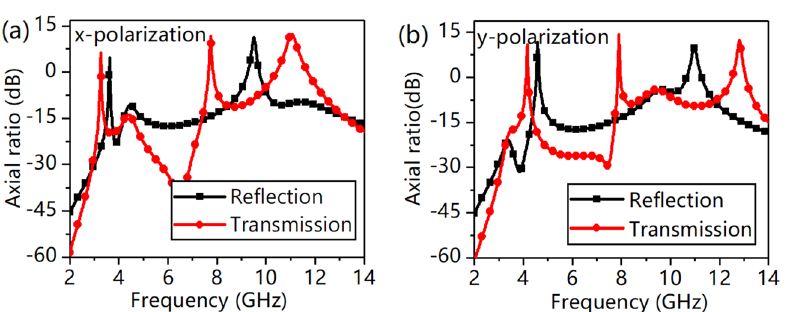
Figure 8. Axial ratio of the cross-polarization to copolarization, ( a ) the axial ratio of the reflection and transmission of an x-polarized incident wave, and ( b ) the axial ratio of the reflection and transmission of a y-polarized incident